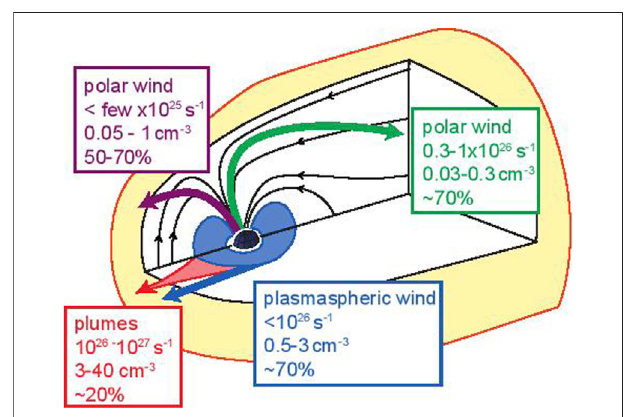
FIGURE 2 | Overview of ion out fl ow from Earth. Regions dominated by low-energy (eV) plasma of ionospheric origin are indicated. Order of magnitude out fl ow rates, densities and percentage of time low-energy ions dominate the density are given. From André and Cully